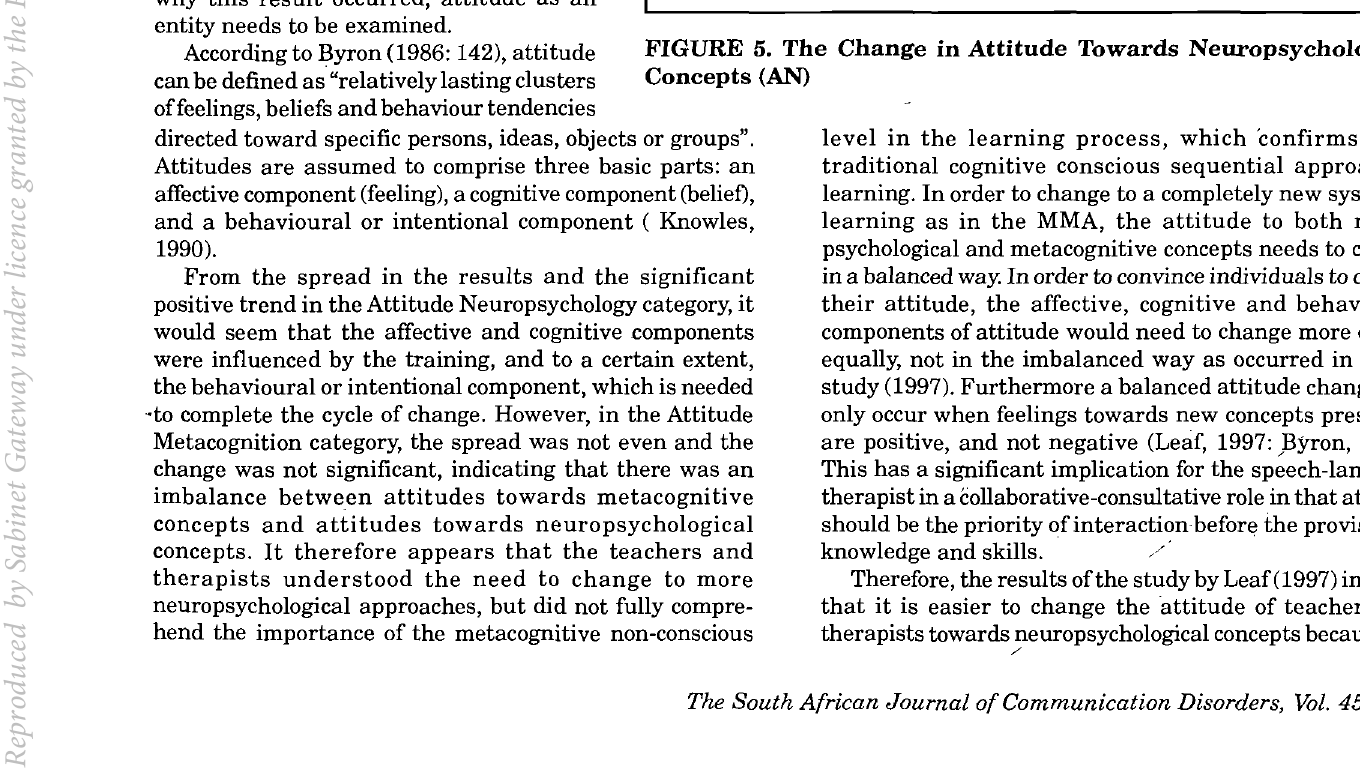
FIGURE 5. The Change in Attitude Towards Neuropsycholo'gical Concepts